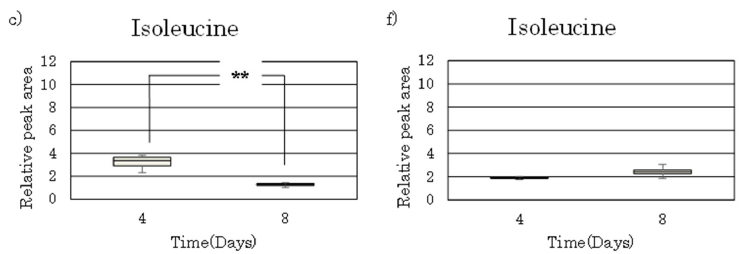
Figure 2. Comparison of BCAAs in adipocytes for 4 and 8 days after differentiation. We performed the metabolome analysis for adipocytes of 2 different time points (day 4 and 8 of adipogenesis). Metabolite relative peak areas are shown as box plots. Alteration patterns of BCAAs are shown for control cells ( a – c ) and cells treated with ISLCs ( d – f ). p values were calculated according to the Student’s t -test; * p < 0.05, ** p < 0.01 (n = 4).